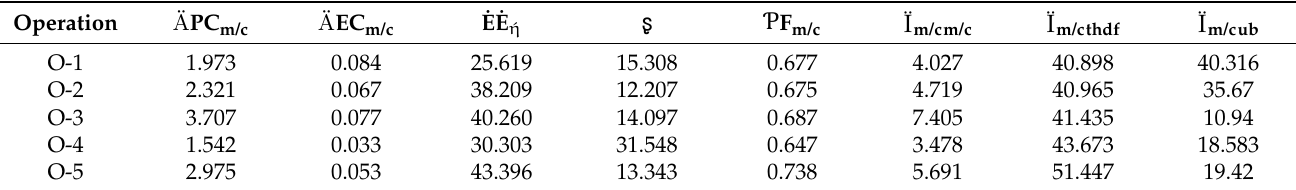
Table 13. Decision matrix of energy responses.